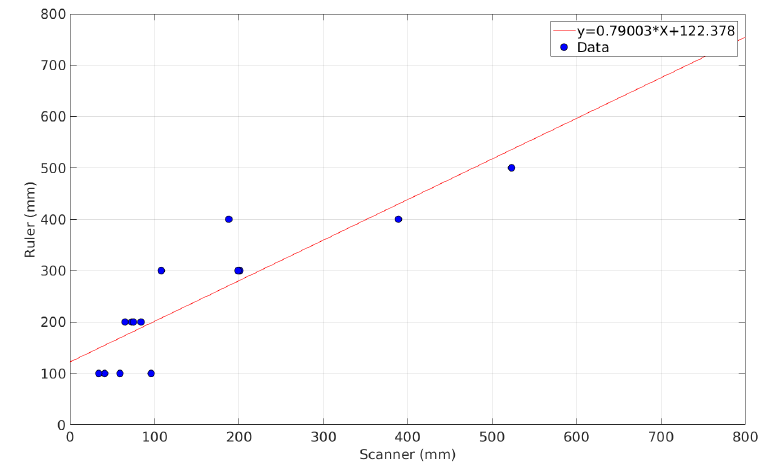
Figure 15. Comparison between the maximum height of the crops measured with a measuring tape and the values acquired with the scanner at a fixed height from the ground.